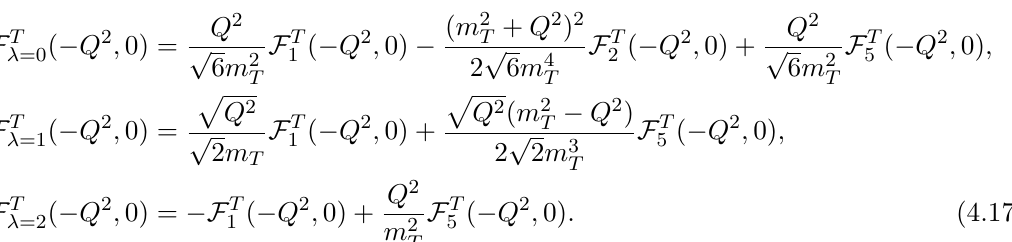
S Figure 3 . Scalar TFF for the f 0 (980), in comparison to the Belle data [57]. The orange 1 F band refers to the quark model from [82], see (3.47), and the green band to the asymptotic BL result (4.16), with e(cid:11)ective decay constant determined by matching to [82] in the doubly-virtual direction. In both cases, the uncertainties are propagated from (cid:0) (cid:13)(cid:13) [4].